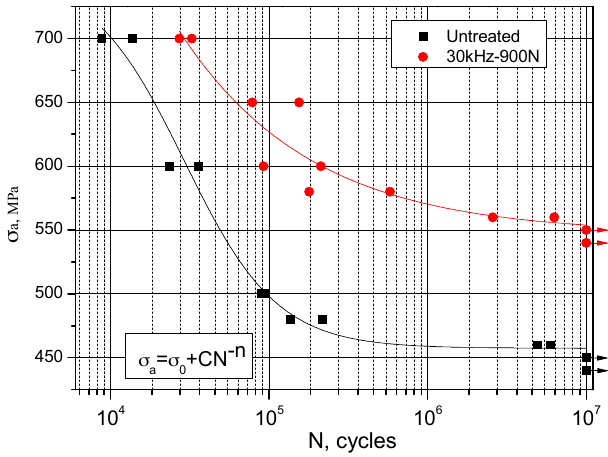
Figure 11. Wöhler curves for MUSR-treated samples at 900 N and untreated samples.